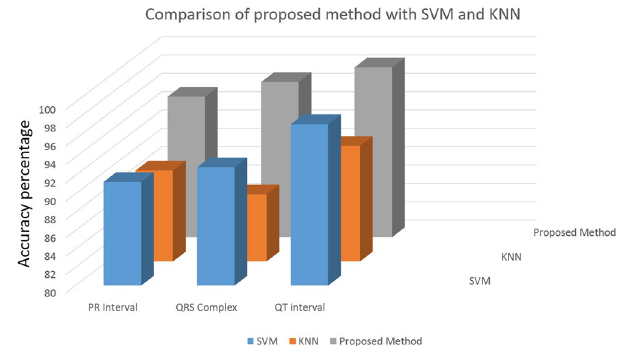
Figure 9. Comparison analysis of SVM, KNN and proposed PSR method.